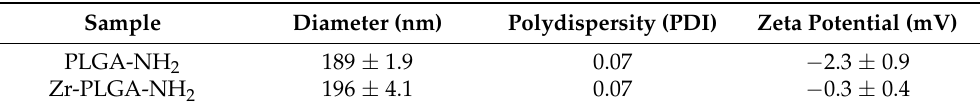
Table 1. Characterization of PLGA-NH 2 and Zr-PLGA-NH 2 NPs: size ( n = 3), PDI ( n = 3) and zeta potential ( n =